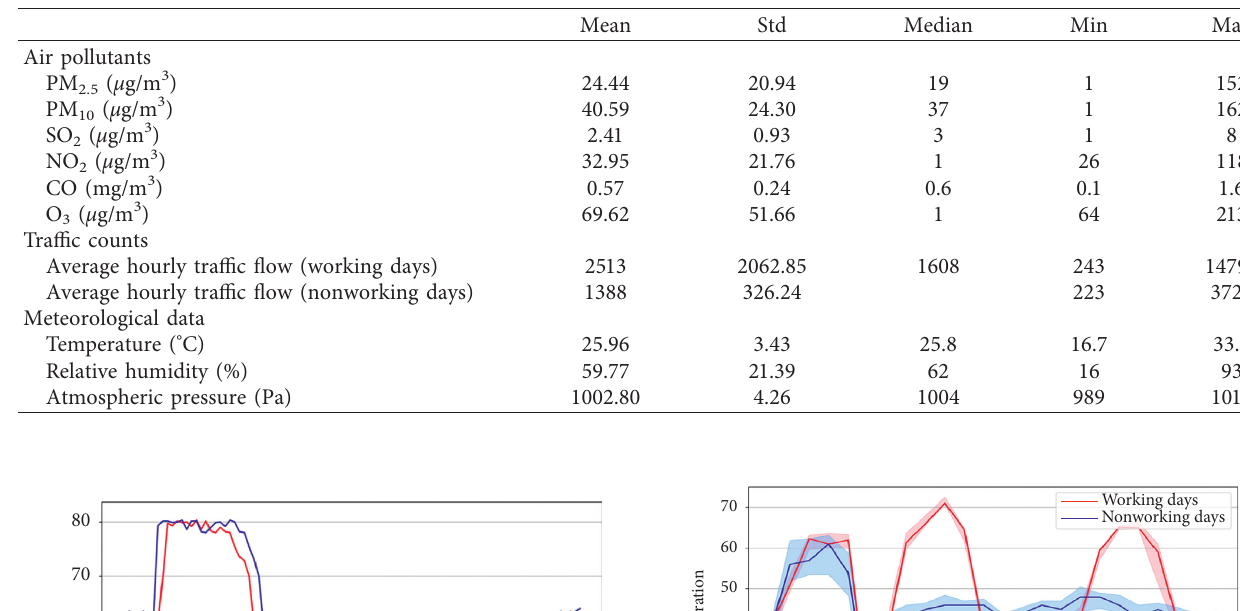
Figure 13: The concentration of PM 2.5 at the Olympic Sports Center monitoring site in August. Table 6: The general summary statistics of Olympic Sports Center monitoring site in August 2019.